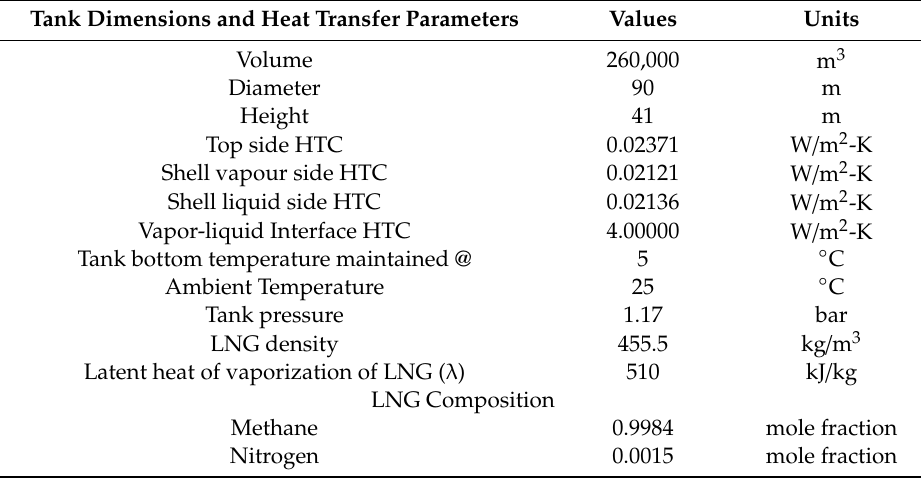
Table 6. LNG storage tank model parameters and simulation